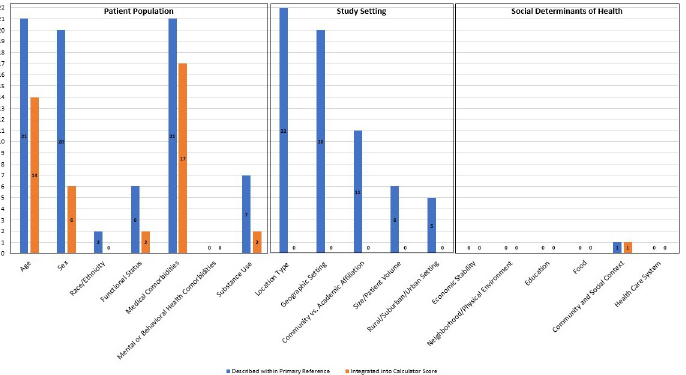
Fig 1. Primary reference and calculator score inclusion of patient population, study setting, and social determinants of health details.